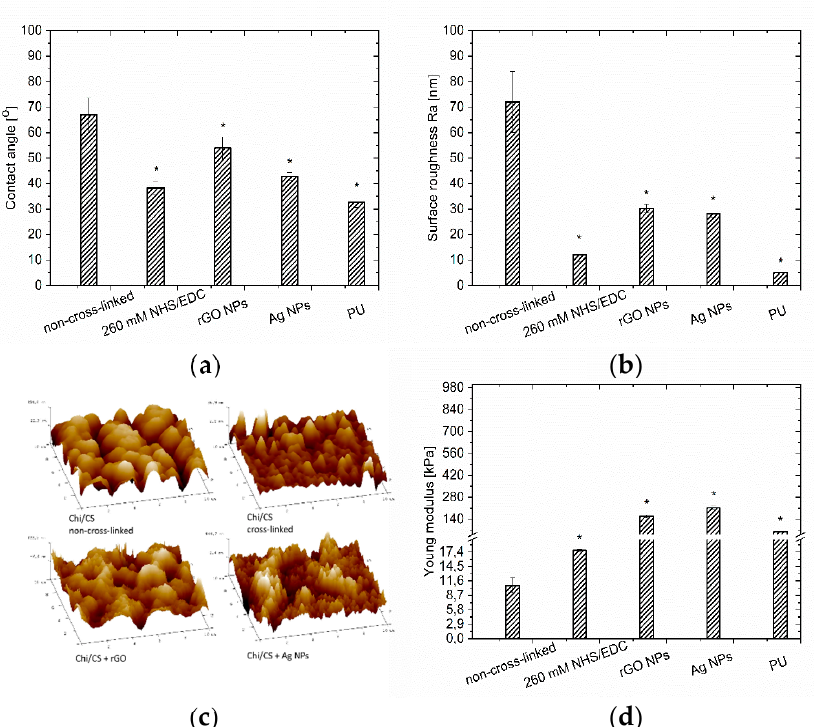
Figure 2. Properties of the Chi / CS films and polyurethane (PU) control: ( a ) wettability; ( b ) surface roughness; ( c ) thickness; ( d ) sti ff ness. Results obtained for non-cross-linked, 260 mM NHS / EDC (N-hydroxysulphosuccinimide / 1-ethyl-3-(3-dimethylaminopropyl) carbodiimide) cross-linked films and samples modified with nanoparticles. The data represent mean ± SD, n = 8; * p < 0.05 vs. non-cross-linked sample.